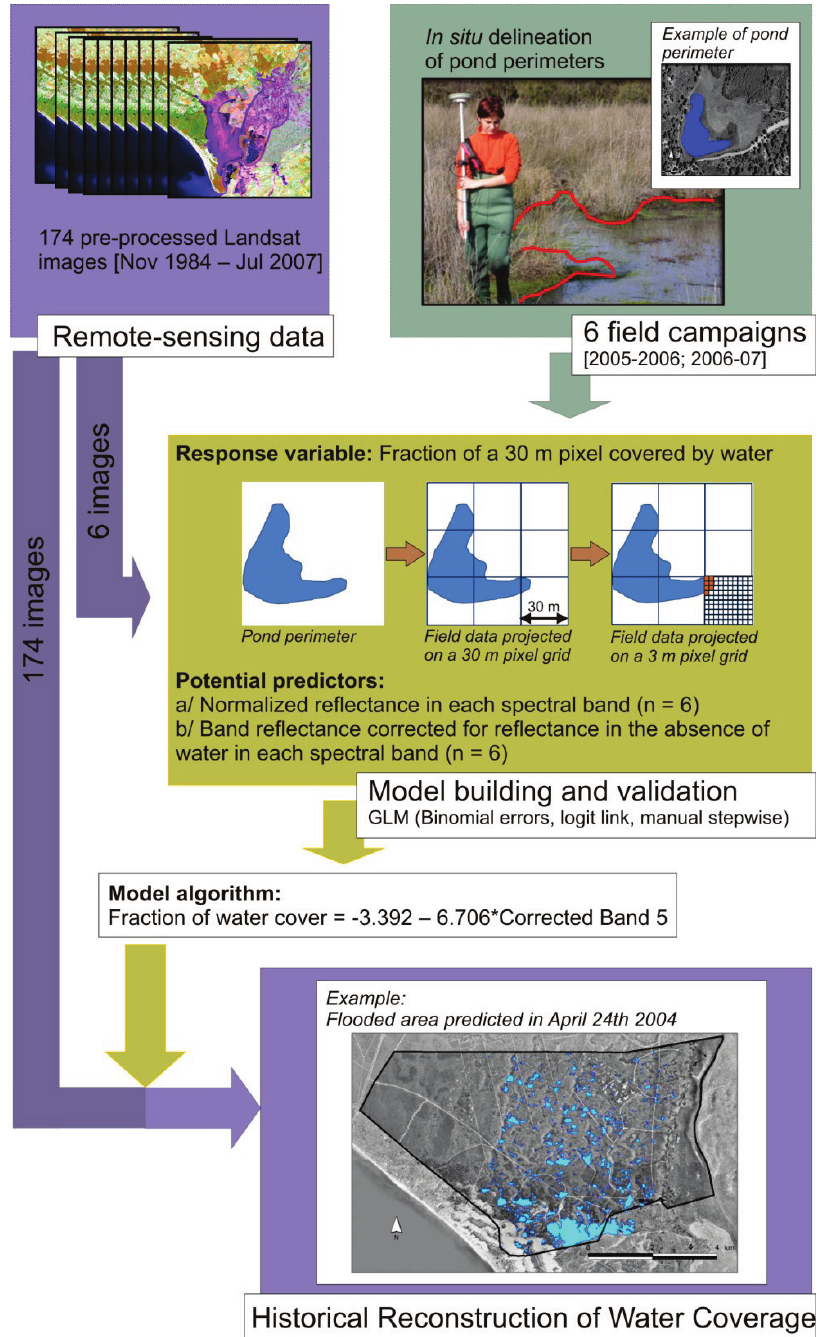
Figure 2. Scheme of the model development and application